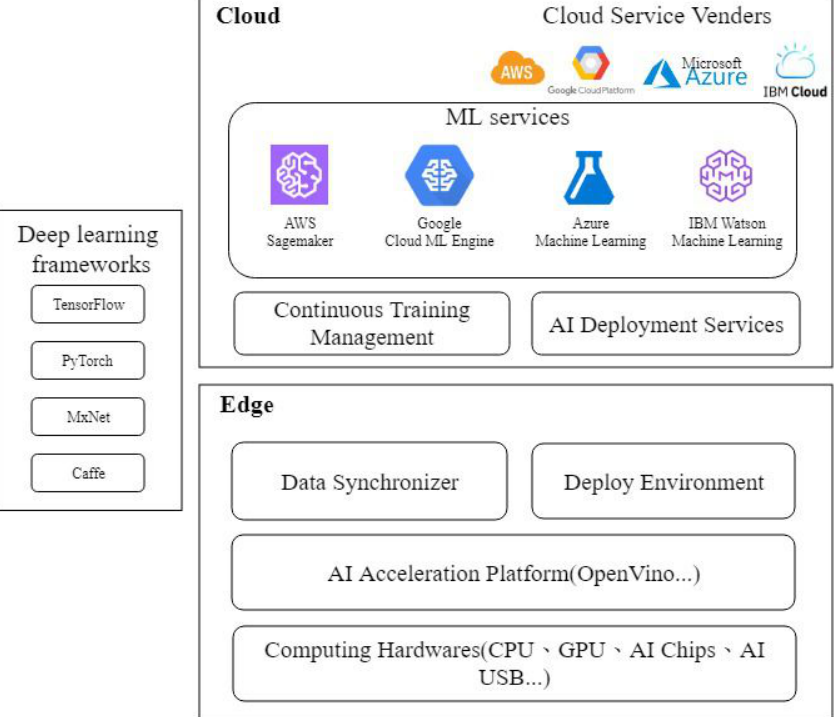
Figure 1. The system architecture of the edge-cloud